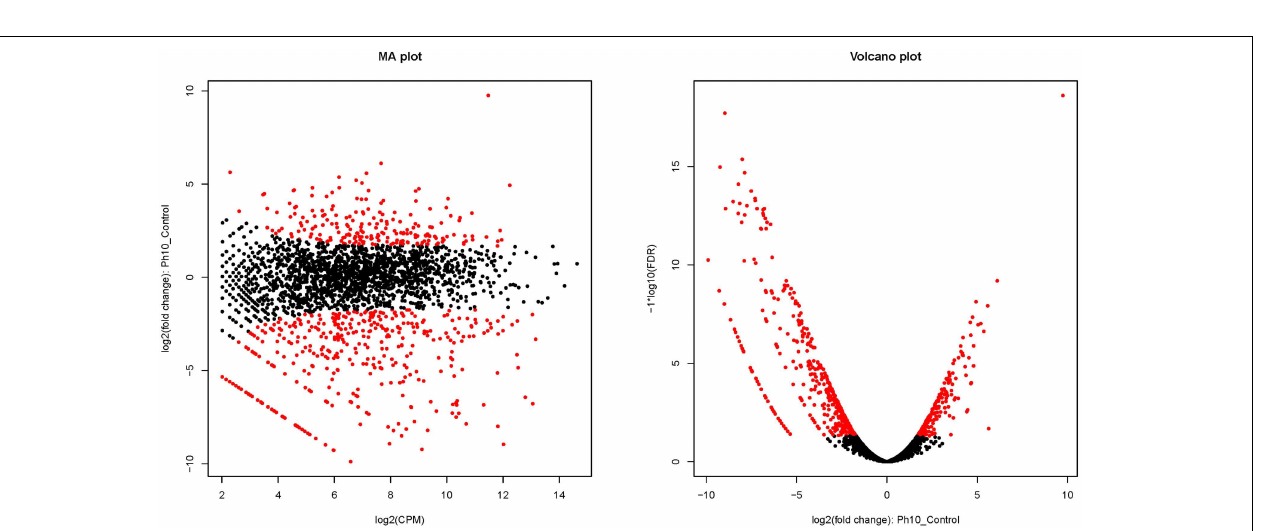
shows the fold-change values between the control and alkaline group based on a log 2 scale. In the figure of a volcano plot, the X-axis shows the fold-change values between the control and alkaline groups based on a log 2 scale, and the Y-axis shows the FDR value of differentially expressed genes based on a -log 10